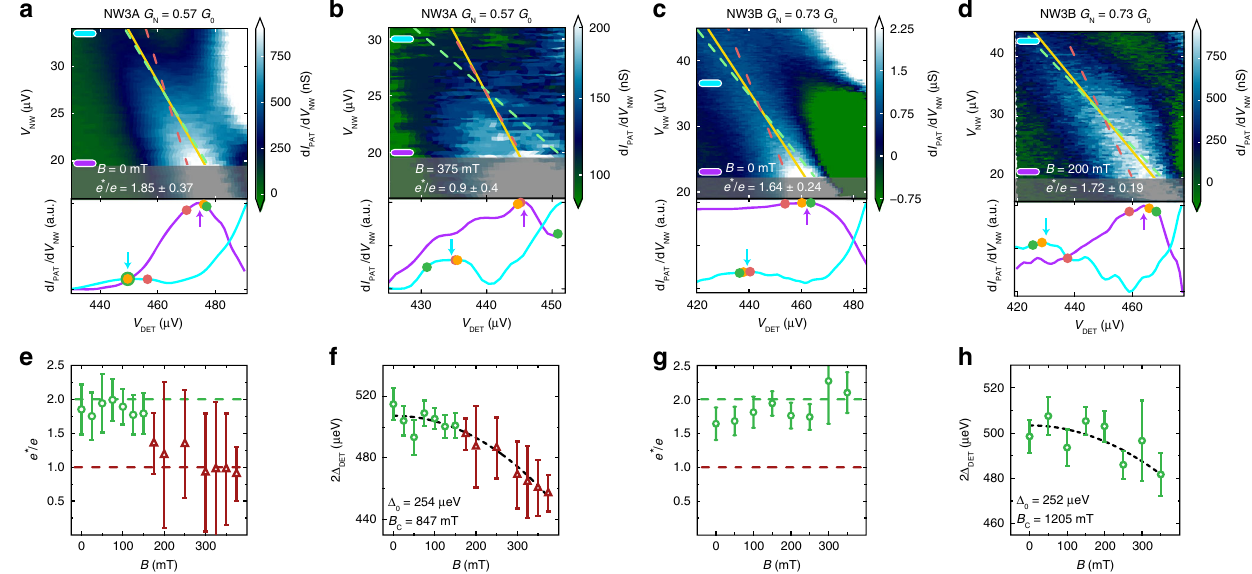
Fig. 3 Gate tuning of the 4 π -periodic radiation regime. Differential transconductance d I PAT /d V NW as a function of V NW and V DET for device NW3 at gate setting A ( a , b ) and setting B ( c , d ) at zero and fi nite magnetic fi elds, respectively. A linear fi t and fi ts with fi xed slopes e * = 2 e and e * = e are shown as an orange line, a dashed green line, and a dashed red line, respectively. Two normalized and smoothed horizontal linecuts are also presented, in which the arrows point to the position of the extracted peaks. The evolution of e * ( B ) and Δ DET ( B ) is shown in ( e , f ) for setting A and in ( g , h ) for setting B. A transition from 2 π - to 4 π -periodic Josephson radiation is observed for gate setting A, but the radiation remains 2 π -periodic for setting B. The gate voltage values are shown in Supplementary Table 2. For the calculation of the error bars, see text and Supplementary Note 2